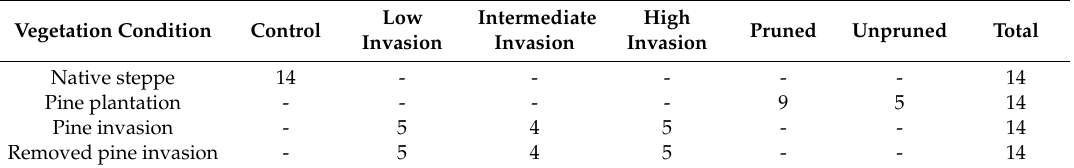
Table 1. Number of sampled plots with each vegetation condition classified according to the level of invasion (invaded plots) or the pruning status (plantations) totaling nine